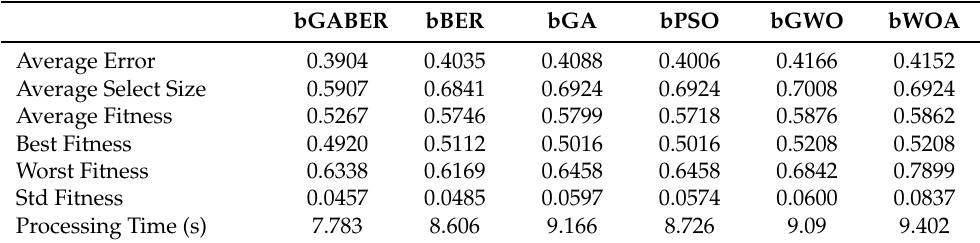
Table 12. Evaluation of the proposed feature selection method when applied to the solar radia- tion dataset.